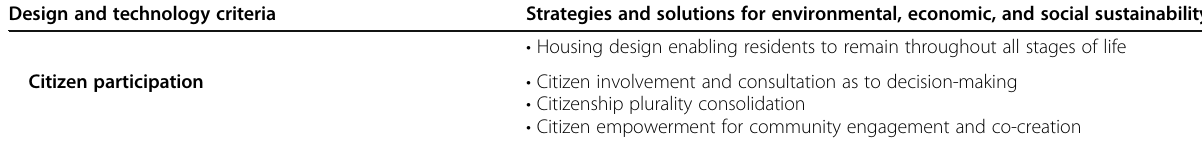
Table 3 The key strategies and solutions of the eco-city district for achieving the three goals of sustainability (Continued) Design and technology criteria Strategies and solutions for environmental, economic, and social sustainability (cid:129) Housing design enabling residents to remain throughout all stages of life Citizen